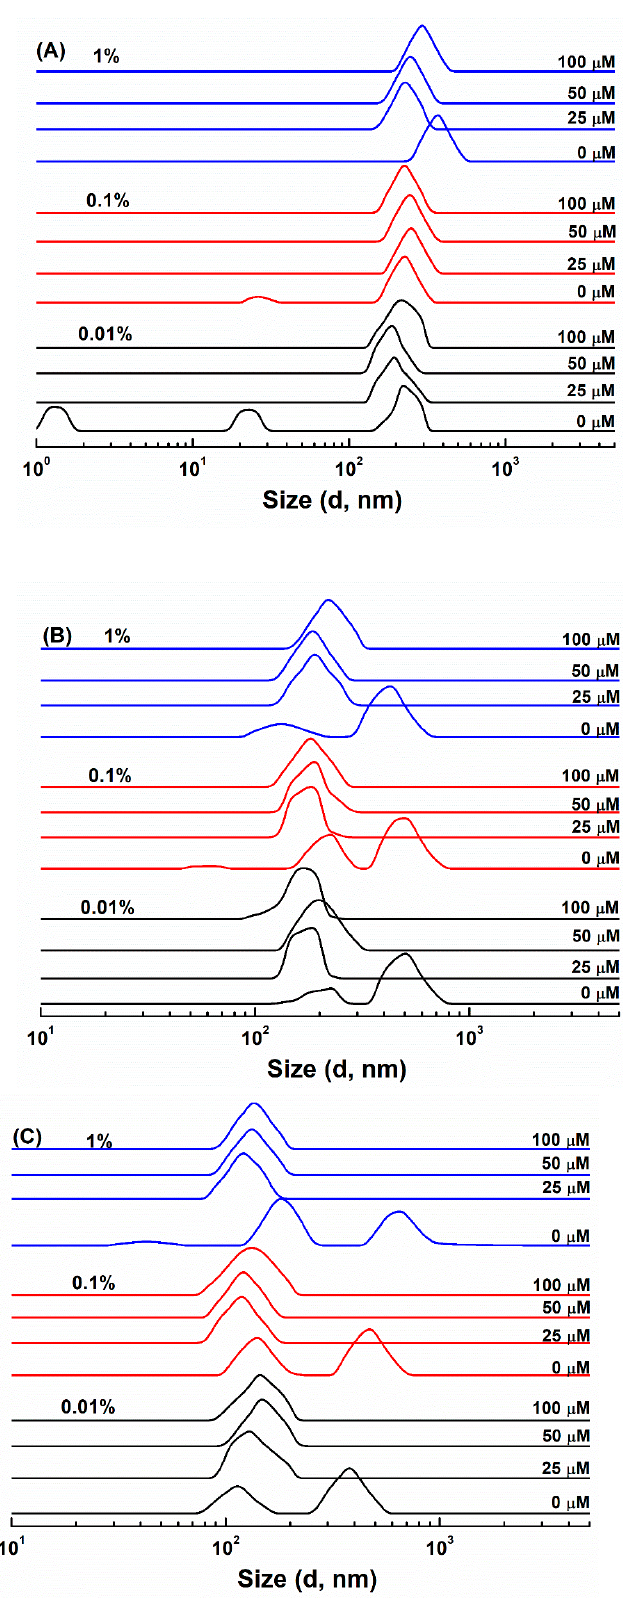
Figure 2. Size distribution of SC ( A ), WPI ( B ) and SPI ( C ) particles in the absence and presence of 25, 50 and 100 μ M resveratrol. The protein concentrations were 0.01%, 0.1% and 1%. Table 1. Amino acid composition of whey protein isolate (WPI) at 1% in the absence and presence of 100 μ M resveratrol (RES) before and after storage for 30 days.